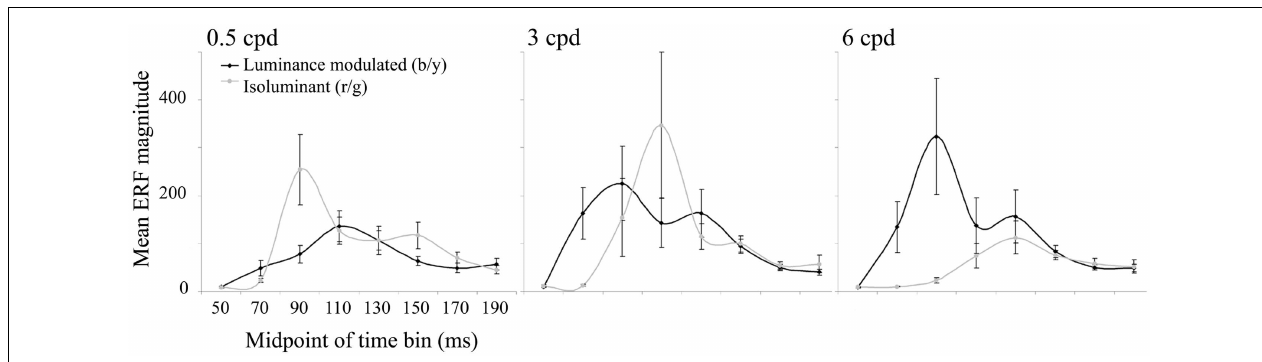
FIGURE 4 |The mean ( n = 10) of the largest ERF in each 20ms time bin from 40 to 200ms is plotted for each condition. Error bars show the SEM. Units are